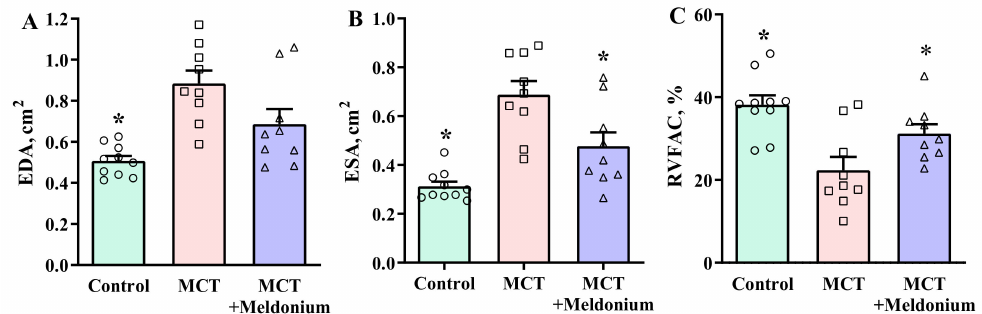
Figure 1. Effects of meldonium administration on the ( A ) end-diastolic area (EDA) of the right ventricle, ( B ) end-systolic area (ESA) of the right ventricle and ( C ) fractional area change of the right ventricle (RVFAC). Treatment with meldonium significantly decreased ESA and increased RVFAC compared with the monocrotaline (MCT) group. The data are shown as the mean ± SEM of 7 to 10 animals. * p < 0.05 vs. the MCT group, one-way ANOVA with Dunnett’s multiple comparison test. The analysis of the echocardiograms of the left ventricle demonstrated that 4 weeks after the administration of MCT, the rats had decreased end-diastolic volume, LV diameter at the end of diastole and cardiac output, although the ejection fraction and fractional shortening were unchanged (Table S1). Treatment with meldonium did not affect the dimensions or functioning of the left ventricle. In summary, these results indicate that treat- ment with meldonium attenuated the development of pulmonary hypertension-induced RV hypertrophy and